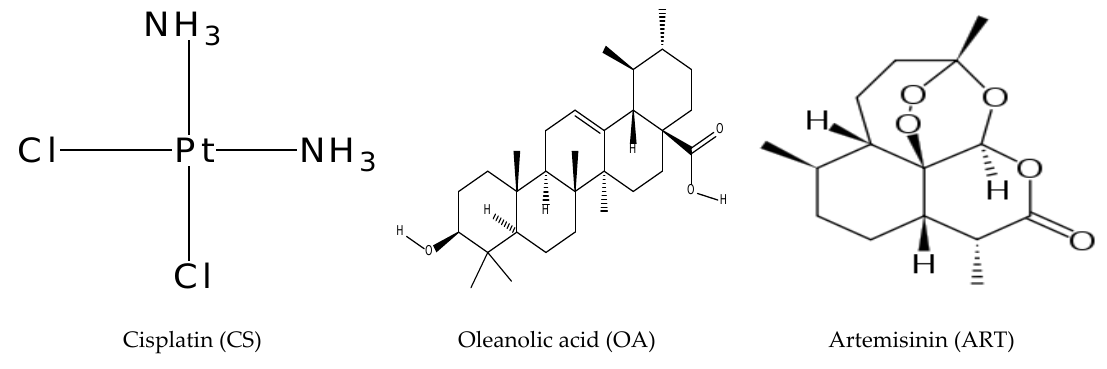
Figure 1. Chemical structure of cisplatin, oleanolic acid, and artemisinin.